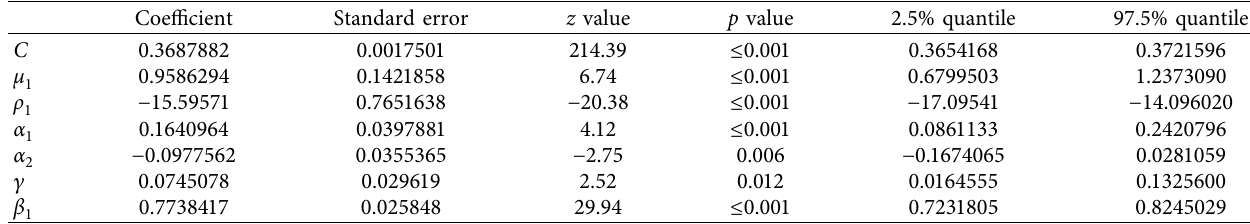
Table 4: The relationship between expected trading volume and open interest and price fluctuations in China’s soybean futures market. Coefficient Standard